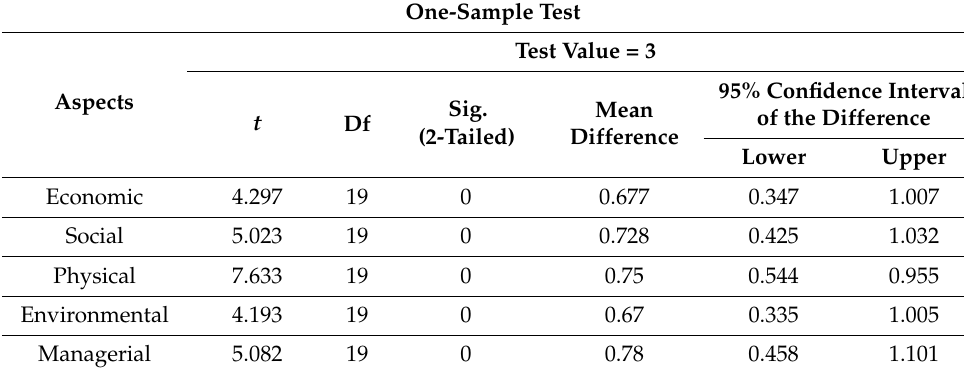
Table 4. Sample t -test